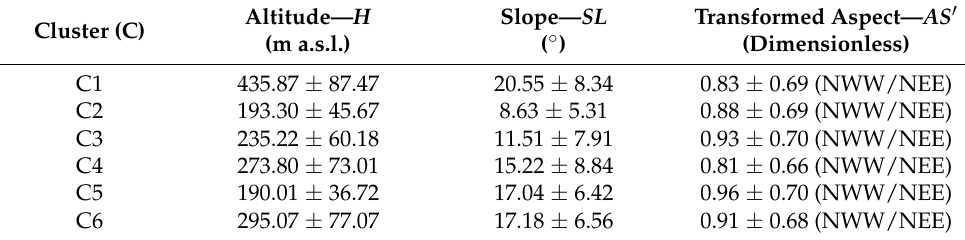
Table 4. Statistics concerning topographic features of clusters—altitude ( H ), slope ( SL ), and trans- formed aspect ( AS (cid:48) ). NW = North-West-looking slopes with no dominance of both N and W; NE = North-East-looking slopes with no dominance of both N and E; NNW = North-West-looking slopes with dominance of N; NNE = North-East-looking slopes with dominance of N; NWW = North- West-looking slopes with dominance of W; NEE = North-East-looking slopes with dominance of E; SW = South-West-looking slopes with no dominance of both S and W; SE = South-East-looking slopes with no dominance of both S and E; SSW = South-West-looking slopes with dominance of S; SSE = South-East-looking slopes with dominance of S; SWW = South-West-looking slopes with dominance of W; and SEE = South-East-looking slopes with dominance of E. Altitude— H Slope— SL Transformed Aspect— AS (cid:48) Cluster (C) (m a.s.l.) ( ◦ ) (Dimensionless) C1 435.87 ± 87.47 20.55 ± 8.34 0.83 ± 0.69 (NWW/NEE) C2 193.30 ± 45.67 8.63 ± 5.31 0.88 ± 0.69 (NWW/NEE) C3 235.22 ± 60.18 11.51 ± 7.91 0.93 ± 0.70 (NWW/NEE) 273.80 ± 73.01 15.22 ± 8.84 0.91 ± 0.68